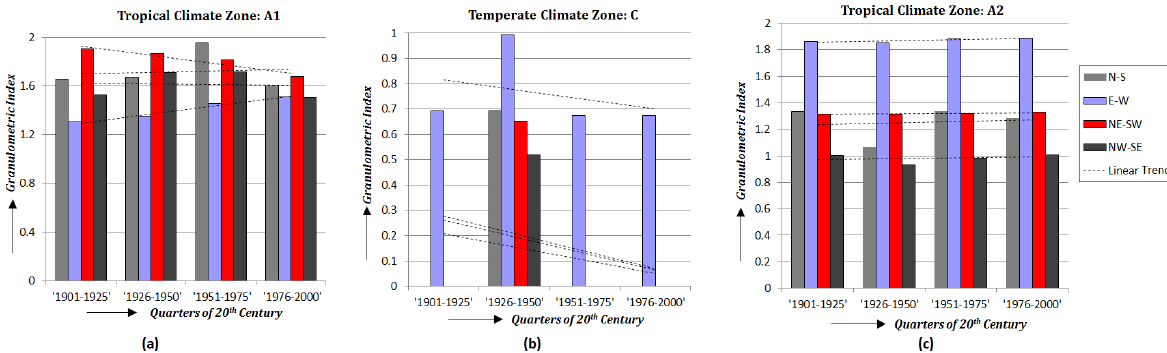
Figure 11. Change in Granulometric indices (corresponding to various structuring elements) throughout 20th century: (a) Tropical climate zone (A1) in Eastern India , (b) Temperate zone (C) , (c) Tropical climate zone (A2) in North-Eastern